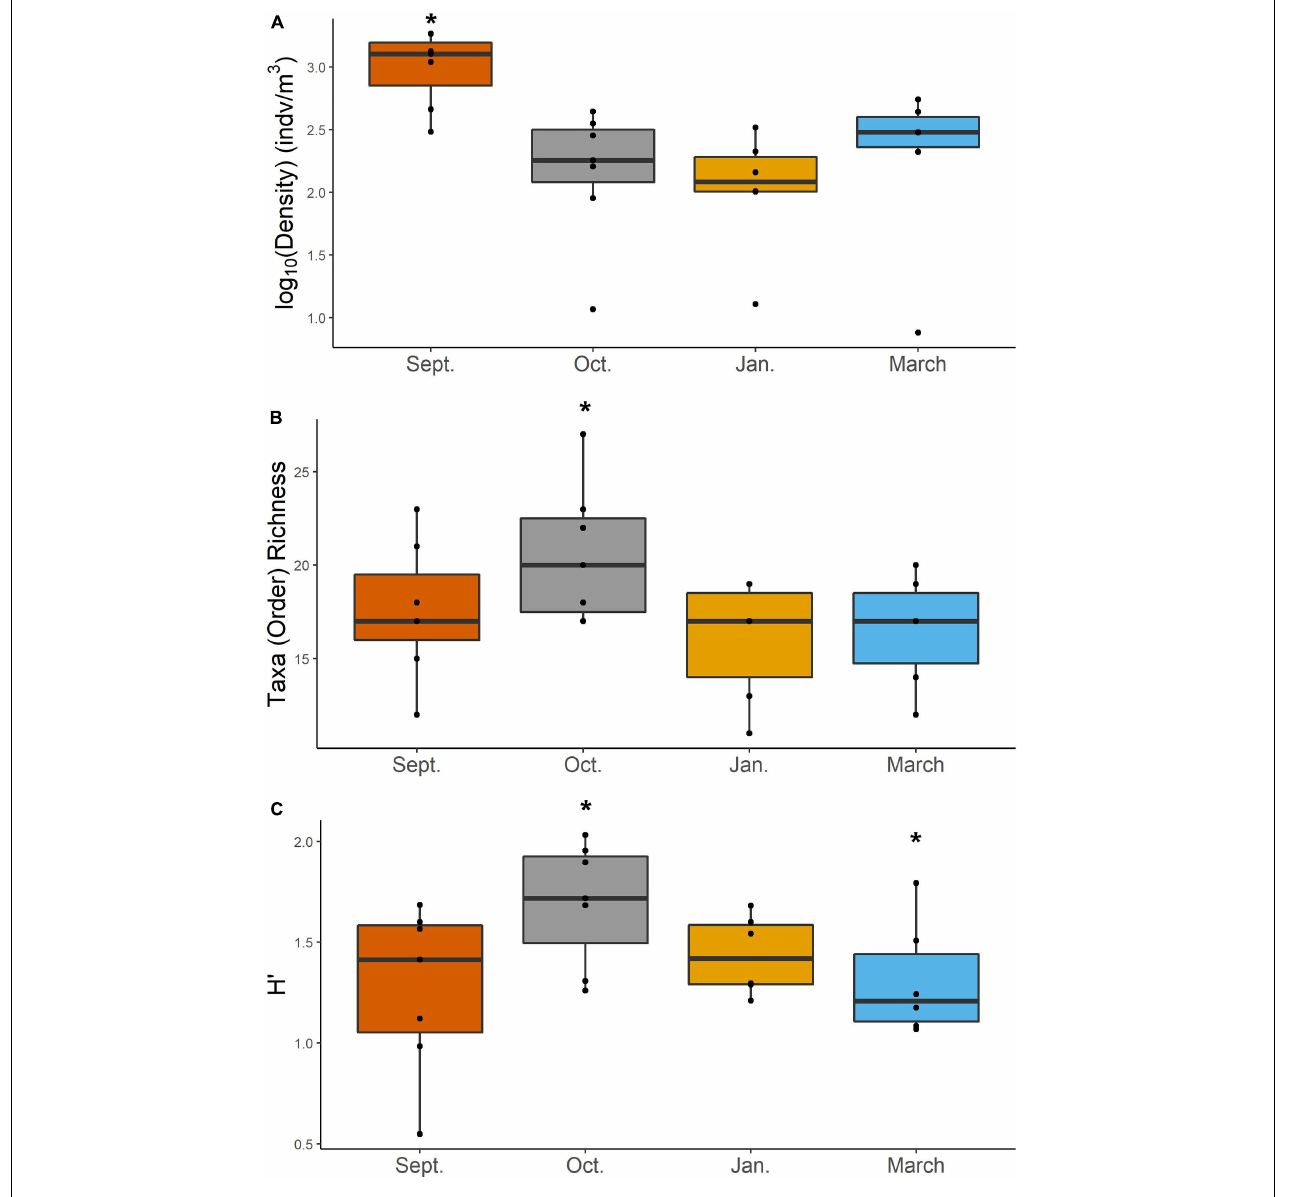
FIGURE 2 | Density (log 10 transformed) (A) , taxa richness at order (B) , and Shannon-Weiner diversity (H (cid:48) ) (C) of mesozooplankton for each cruise. Asterisk denotes groups that are significantly different based on a two-way ANOVA and post-hoc Tukey test. Differences in abundance were determined using a Kruskal–Wallis and pairwise-Wilcox